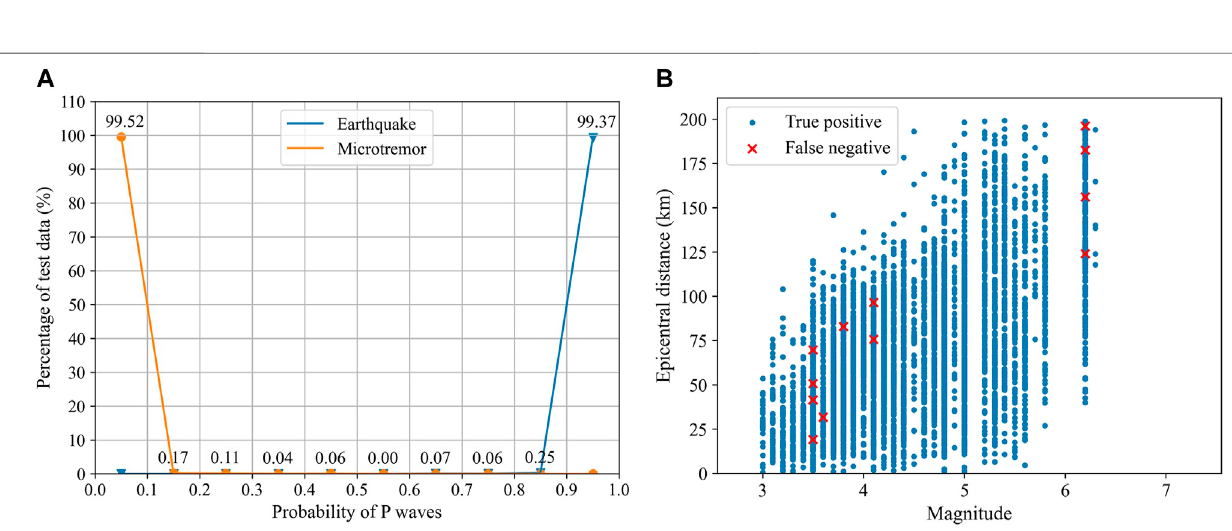
FIGURE 7 | (A) The relationship between the percentage and output probability for the testing set. The earthquake data are concentrated in the 0.9 – 1.0 interval, and the microtremor data are concentrated in the 0 – 0.1 interval. Note that only half of the ordinate values are marked in the fi gure, including microtremor data with an output probability of 0 – 0.5 and seismic data with an output probability of 0.5 – 1.0. (B) The relationship between the epicentral distances and magnitudes of true positive records and false negative records with an epicentral distance ≤ 200 km for the testing set. The blue dots represent true positive records, and the red crosses represent false negative